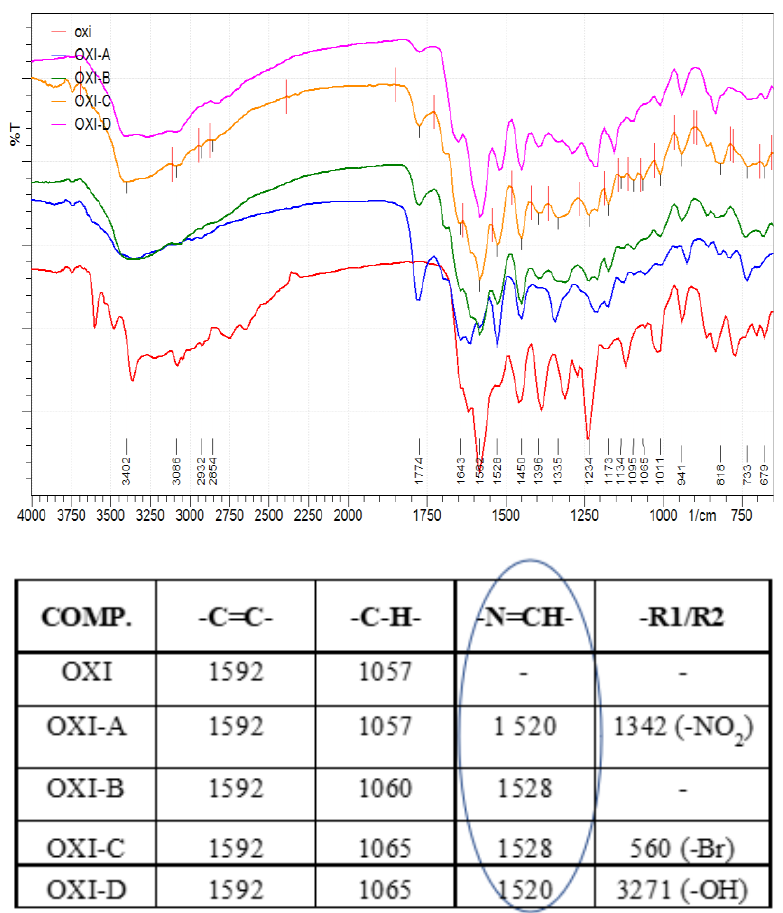
8 of 20 Figure 2. Synthesis of oxytetracycline derivatives. OXI-A (R 1 = – NO 2 ; R 2 = – H); OXI-B (R 1 = – H; R 2 = – H); OXI-C (R 1 = – H; R 2 = – Br); OXI-D (R 1 = – H; R 2 = – OH). 3.2. Characterization of Oxytetracycline Derivatives 3.2.1. Spectral Data